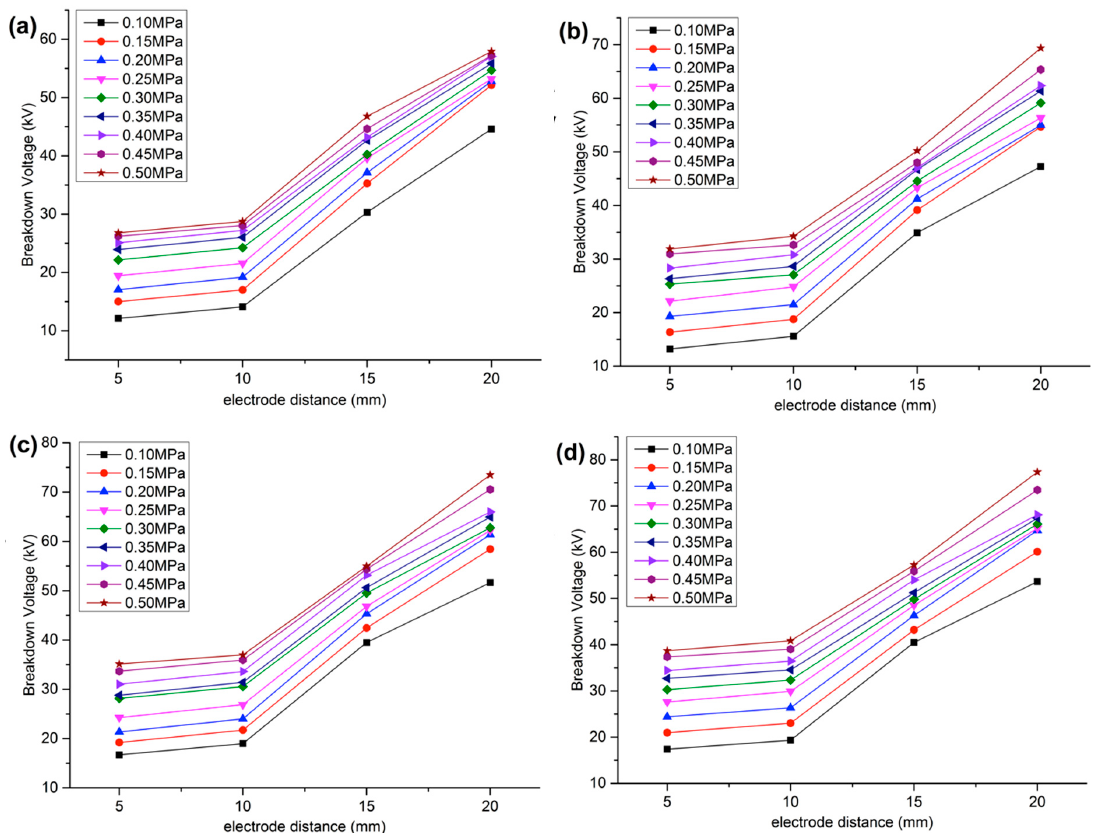
Figure 5. The breakdown voltage of c-C 4 F 8 /N 2 gas varying with the electrode distance for k of ( a ) 5%, ( b ) 10%, ( c ) 15%, and ( d ) 20%.